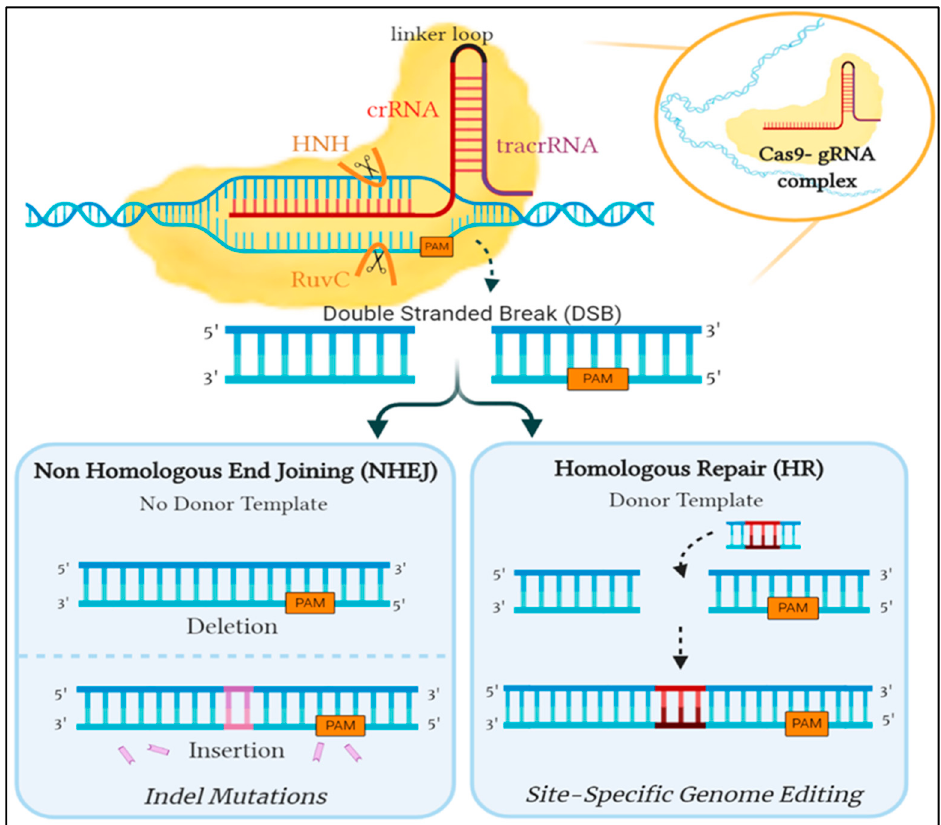
Figure 2. An overview of the repair mechanism associated with induced Cas9 double-stranded DNA break. Cleavage is induced by the binding of Cas9- gRNA complex to its complementary sequence on foreign DNA. In eukaryotes, this is amended by either of two mechanisms: the error-prone Non-Homologous End Joining (NHEJ) or Homologous Repair (HR), which is utilized for genome editing by providing a donor template. Created with Biorender.